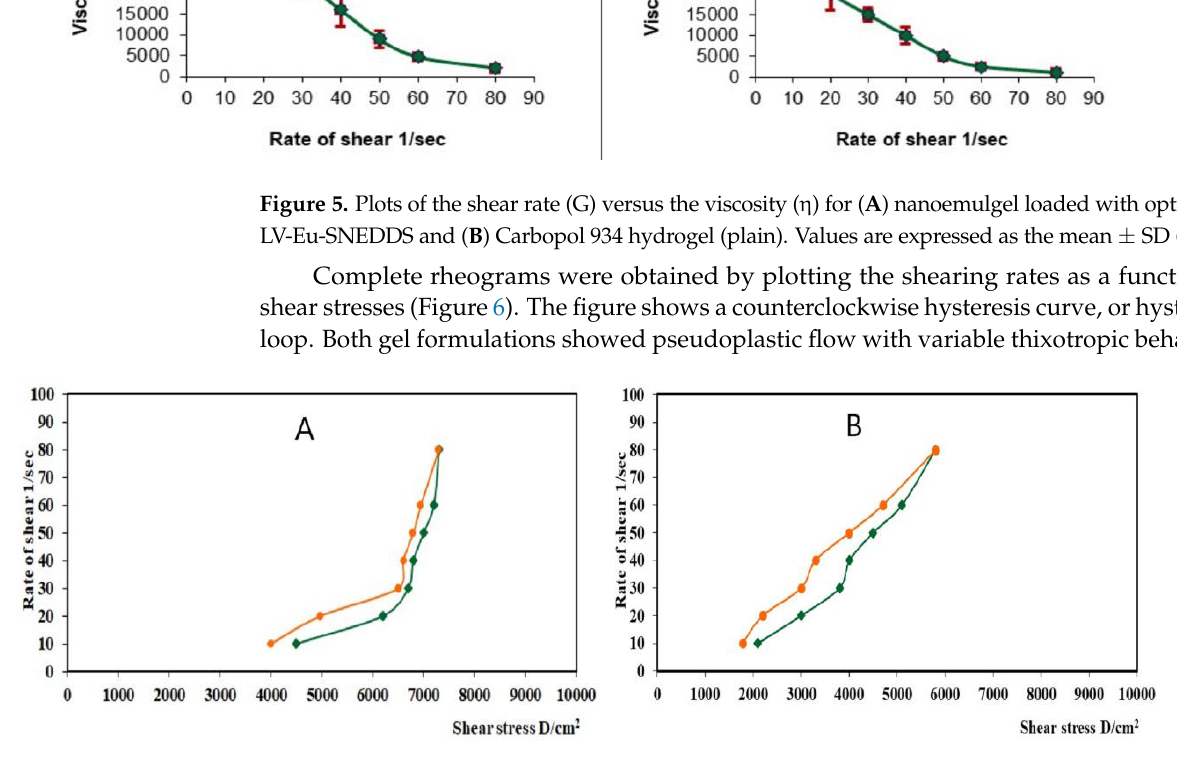
Figure 6. Rheograms of ( A ) nanoemulgel loaded with optimized LV-Eu-SNEDDS and ( B ) Carbopol 934 hydrogel (plain).